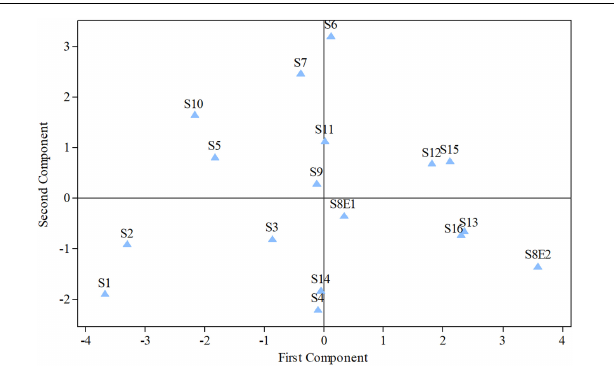
FIGURE 5 | Diagram produced from the examination of the first and second components of Pimpinella species (strongly linked to the placement of the centromere and the length of the complements, accordingly). S1 ( P. affinis ), S2 ( P. eriocarpa ), S3 ( P. tragium ), S4 ( P. saxifrage ), S5 ( P. aurea ), S6 ( P. tragioides